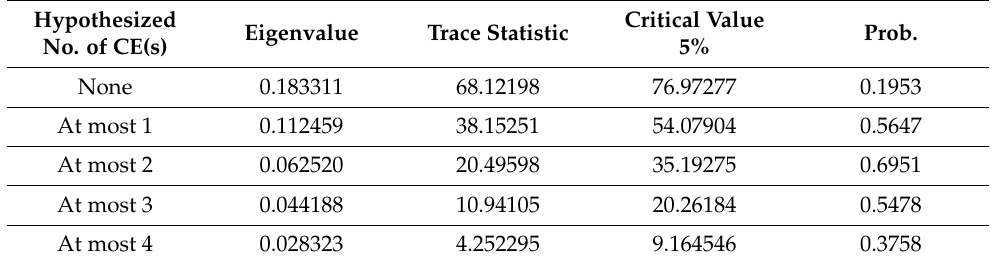
Table 6. Trace statistic—Johansen cointegration method (pre-vaccine period).